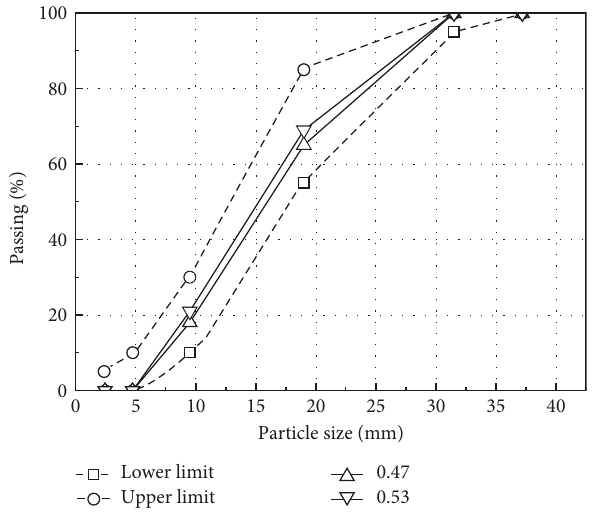
Figure 1: Grading of coarse